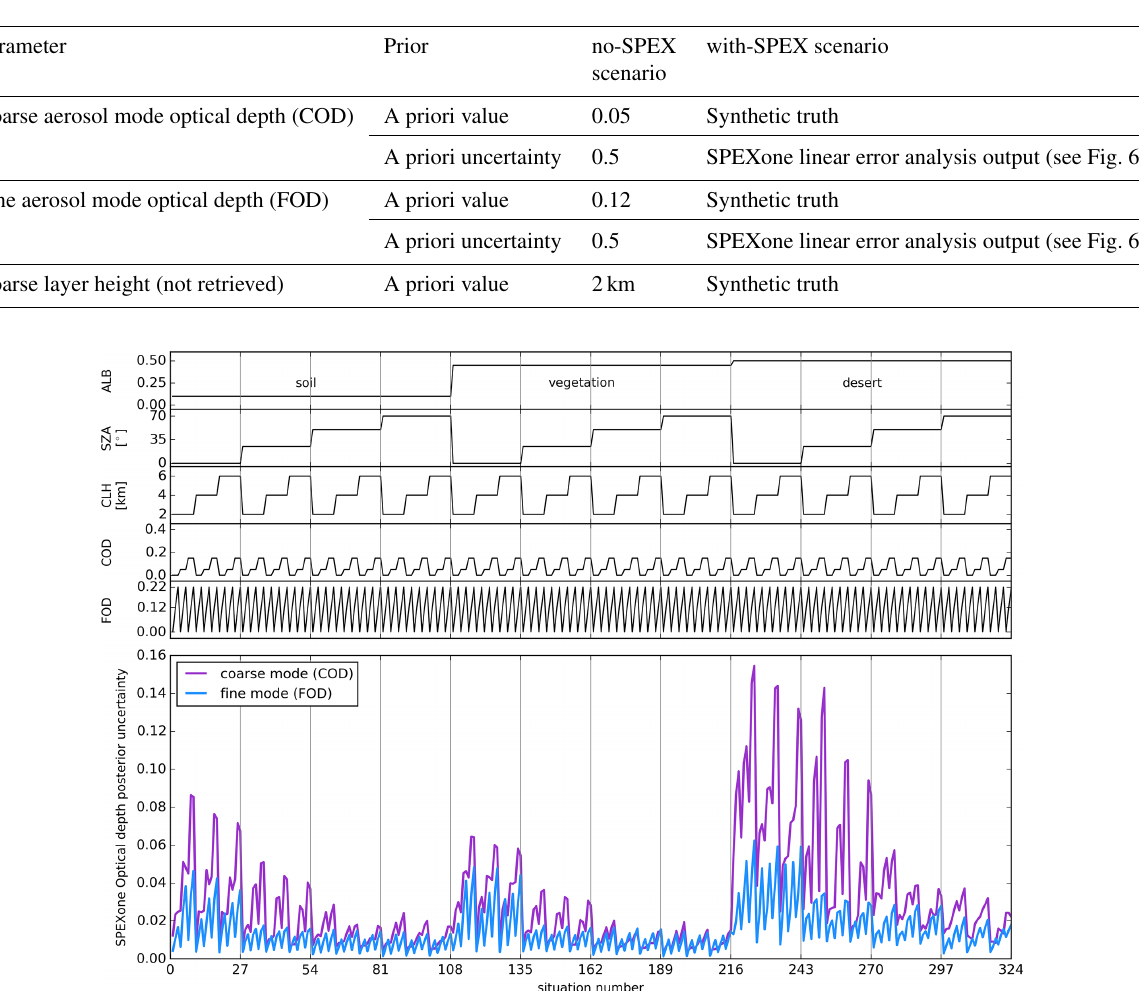
Figure 6. SPEXone linear error analysis results for all the 324 atmospheric and observational situations used in this work. SPEXone COD and FOD posterior uncertainties are plotted against the situation number: the top five panels detail the ALB (0.7µm), SZA, CLH, COD and FOD values defining all 324